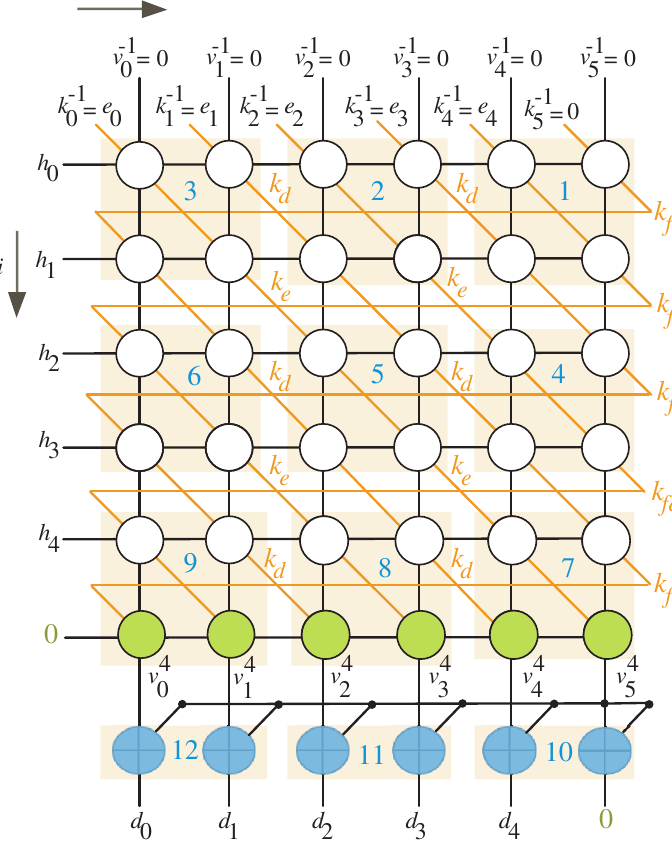
Figure 2. Scheduling time for n = 5 and l =